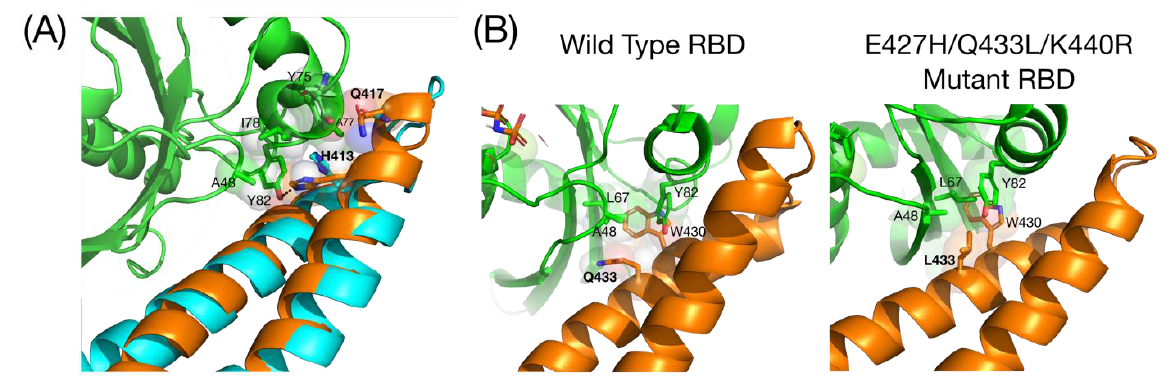
Figure 2. Structures of the free RBD and the RBD-RalB complex. ( A ) Comparison of the free RBD (cyan) superimposed on the RBD RalB complex (RBD = orange, RalB = green) (2KWH, 2KWI). The helix in the bound RBD extends, with Gln417 pointing in the same direction as His413. Interactions involving His413 and Gln417 are shown with the sidechains in spacefilling representation superimposed with sticks: carbons are the same colour as the ribbon, oxygen is red and nitrogen is blue; ( B ) Comparison of the hydrophobic pocket of WT RBD and the tighter binding E427H/Q433L/K440R mutant (6ZQT). Residues in the hydrophobic pocket round Trp430 is shown with the sidechains in spacefilling representation superimposed with sticks. Colour scheme is the same as in ( A ).